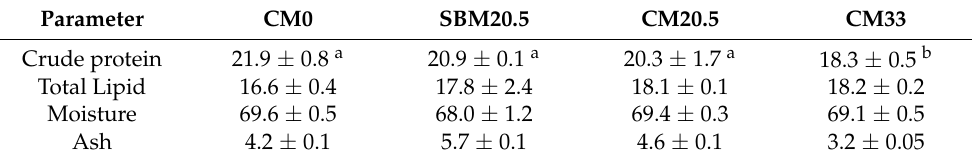
Table 6. Proximate composition (%) of the whole-body carcass obtained after 60 days feeding period in red seabream fed diets formulated by replacing fish meal with camelina meal at 0% for reference diet (CM0), 20.5 g/kg with soybean mean (SBM20.5), 20.5 g/kg with camelina meal (CM20.5) and 33 g/kg camelina meal (CM33).